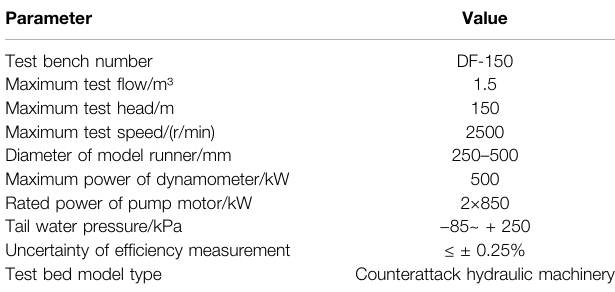
FIGURE 9 | Display effect of hollow glass beads.